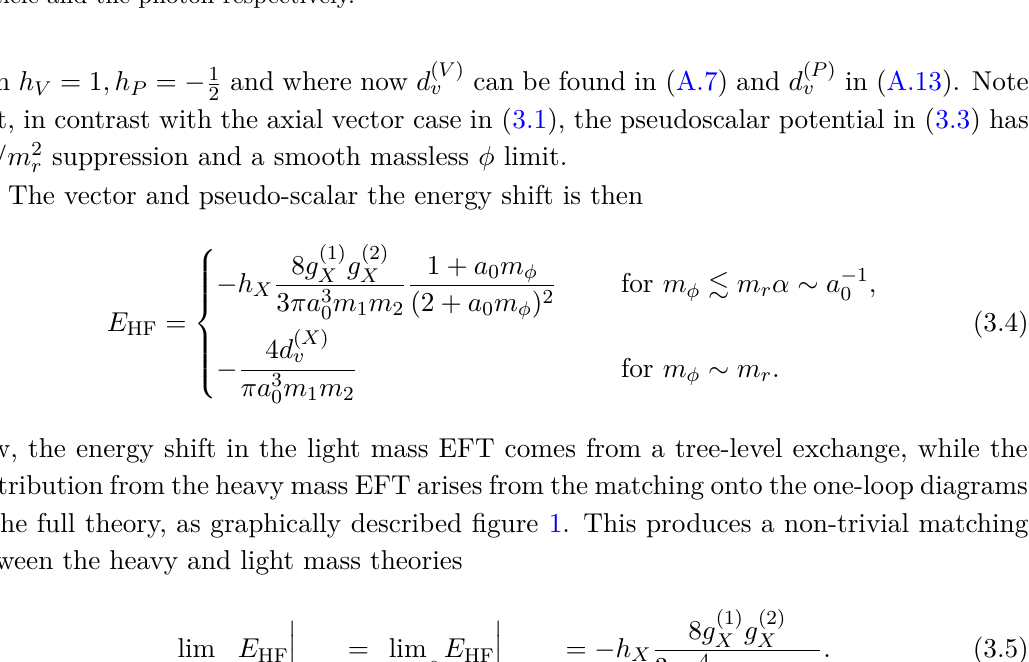
Figure 1 . Graphic representation of the matching between the full theory and the NREFT for the HF pseudo-scalar potential in the light and heavy mass theories. Continuous lines represent the fermionic components of the bound state, while dashed and wiggly lines represent the pseudoscalar particle and the photon